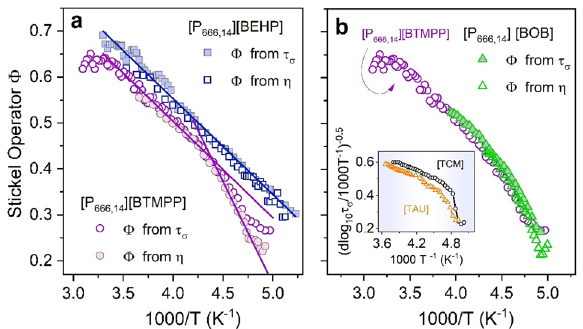
Figure 4. ( a ) The Stickel plots of conductivity relaxation times τ σ and viscosity η for [P 666,14 ][BEHP] and